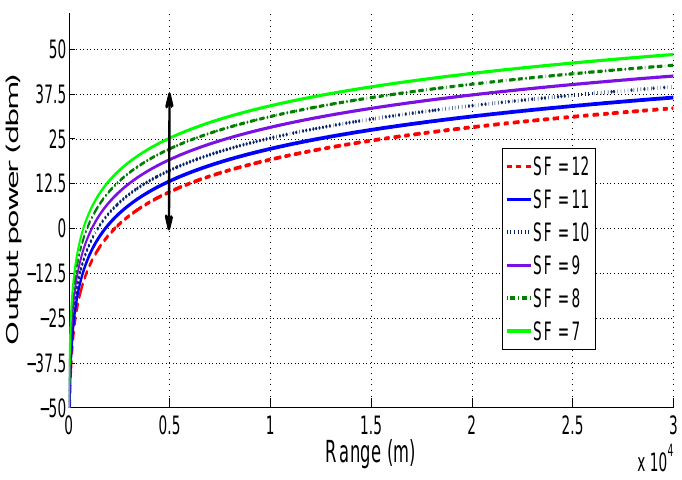
Figure 11. Required output power vs. LoRaWAN